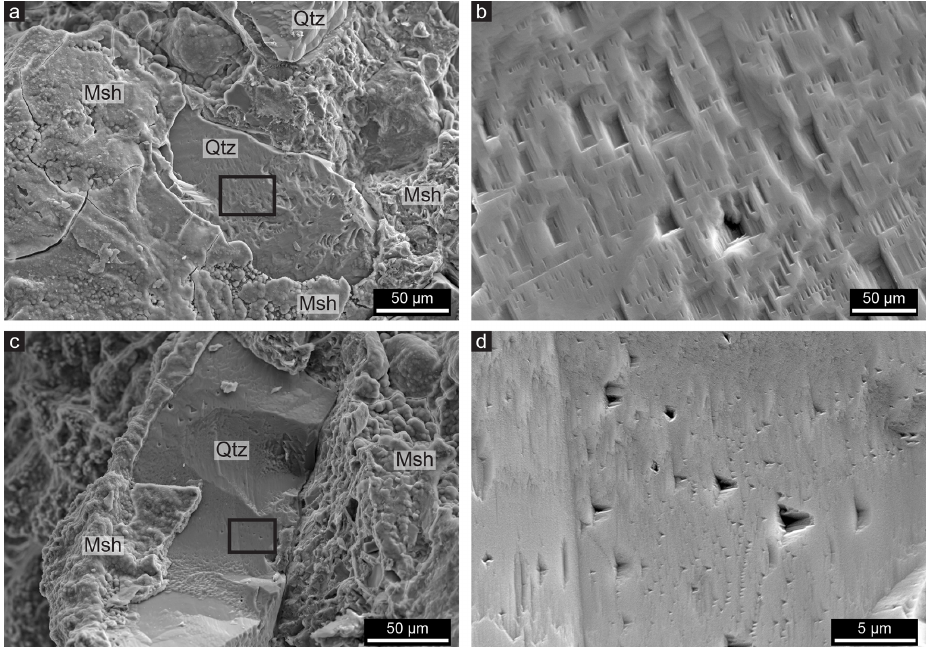
Figure 6. SE images from SEM, showing etch pits on quartz (Qtz) grains that are embedded in magnesium silicate hydrate cement (Msh). (a) A quartz grain with rectangular etch pits on the surface; the box indicates the location of (b) . (b) Rectangular etch pits of varied sizes; note that all have the same orientation and that some are aligned. The dislocation density is 10 10 cm − 2 . (c) A quartz grain with triangular etch pits on the surface; the box indicates the location of (d) . (d) Triangular etch pits on a quartz surface that vary in size but have an identical orientation; note that some of the smaller etch pits are